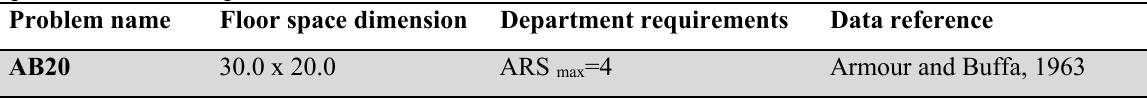
Specification of the problem set Problem name